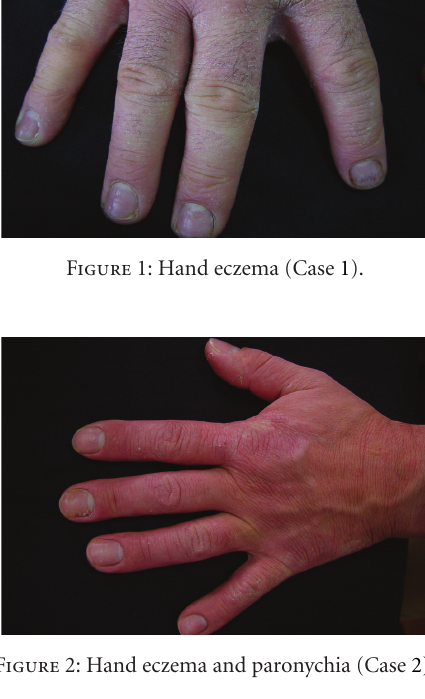
caused by contact with proteinaceous material observed in sandwich